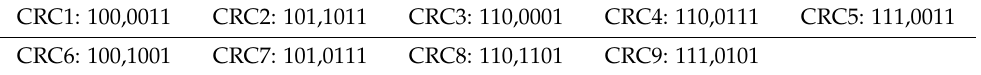
Table 1. The binary form of the generating polynomials of used Cyclic Redundancy Checks